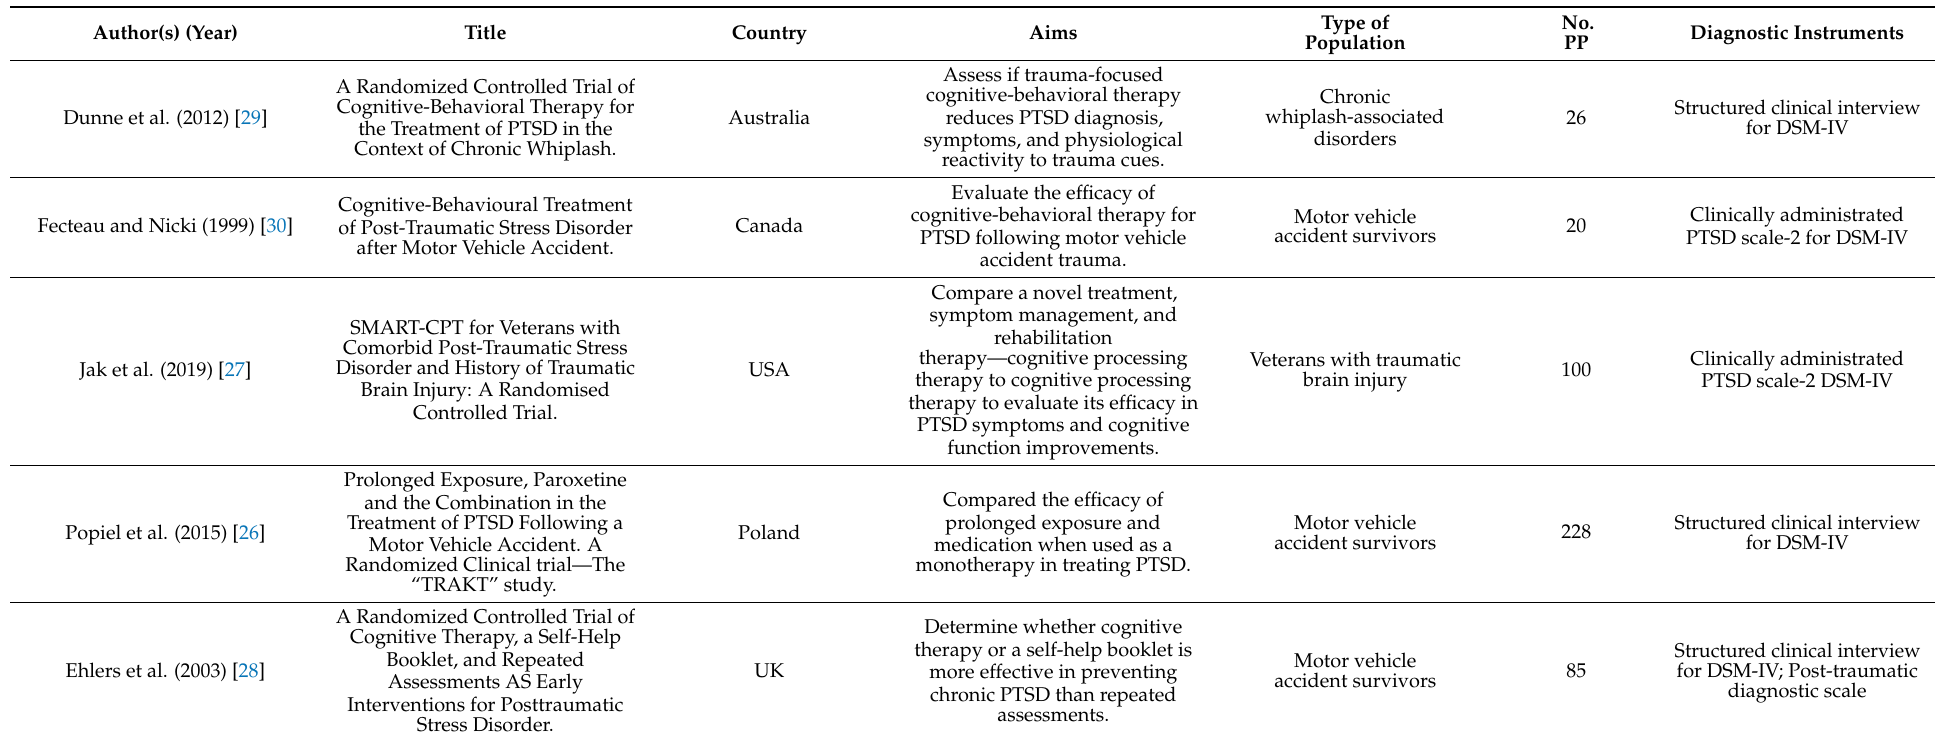
Table 1. Characteristics of included